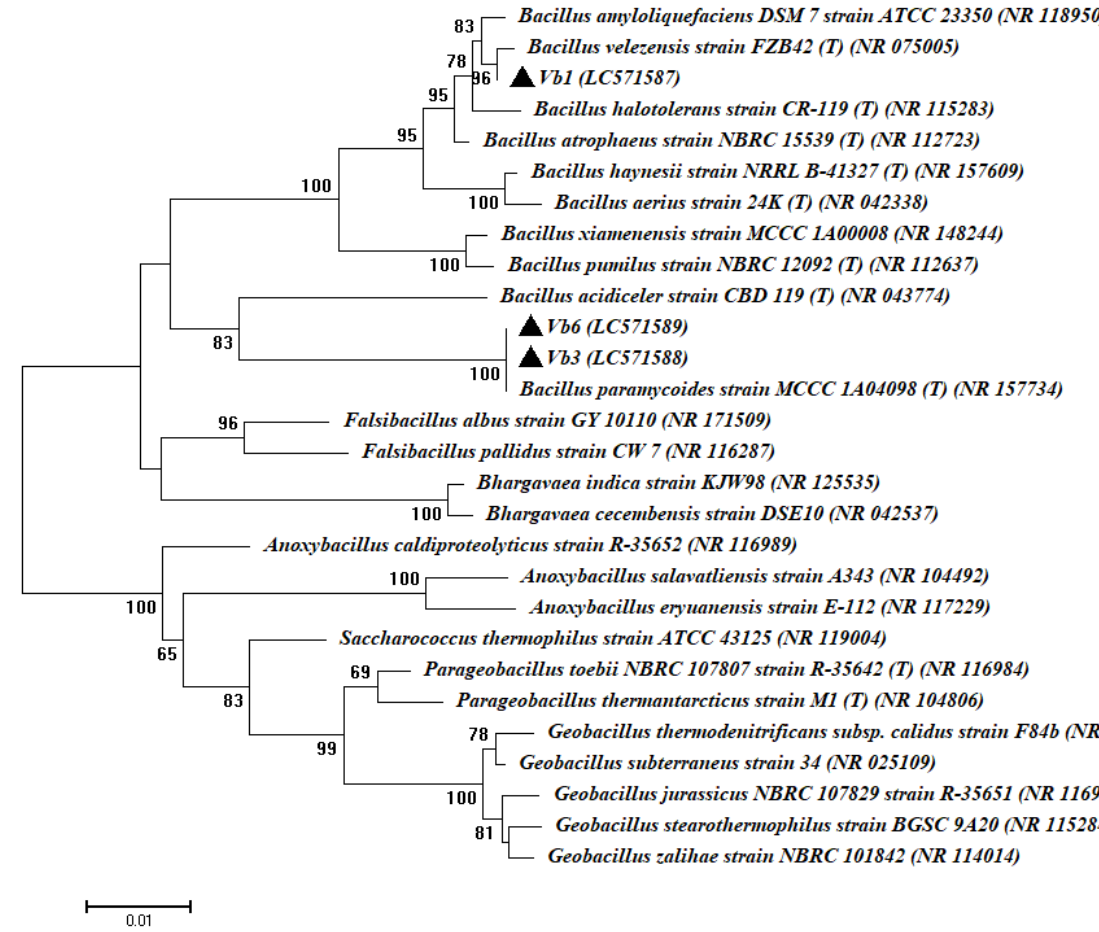
Figure 2: Phylogenetic analysis of 16sr RNA sequences of the bacterial isolates with the sequences retrieved from NCBI. The analysis was conducted with MEGA 7 using the neighbor-joining method with bootstrap value (1000 replicates).